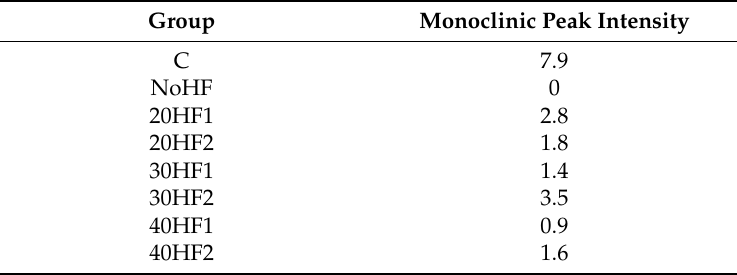
Table 4. Monoclinic peak intensity for each group (%).